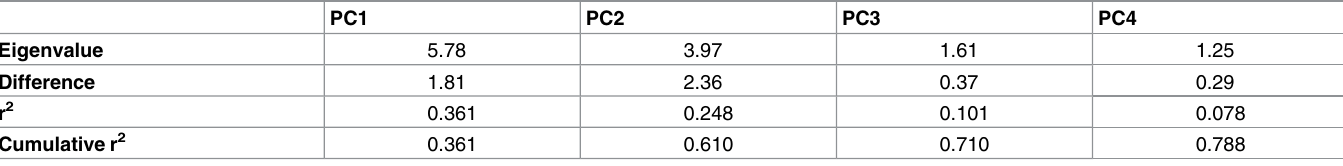
the load-displacement curve, compared to mice fed the other three diets, Fig 12F. This is a function of GMP reducing the brittleness of the bone. Both Fat-Free and Fat Mass Are Correlated with Bone Status Correlational analysis was used to examine the relationship between markers of body composi- tion, including visceral fat weight, subcutaneous fat weight, brown fat weight, gastrocnemius muscle weight, fat-free mass, and fat mass, and markers of bone status. Results are displayed in Table 9, and the significant relationships are shown in Fig 13. Fat-free mass had the greatest impact on mineralization of the bone as reflected in increased BMC and BMD with high-fat feeding, Fig 13A and 13D. Max load, reflective of the strength of the bone, is significantly related to visceral fat weight, subcutaneous fat weight, fat-free mass, and fat mass with the largest impacts coming from the weight of visceral and subcutaneous fat tissues. Bone size mea- sures, cross-sectional area and perimeter, are significantly related to visceral fat weight, subcu- taneous fat weight, fat-free mass, and fat mass. All markers of fat were negatively correlated with post-yield displacement, a measure of ductility. Post-yield displacement decreased as total fat mass, and the mass of subcutaneous, visceral and BAT increased (Table 9). Table 6. Principal Component